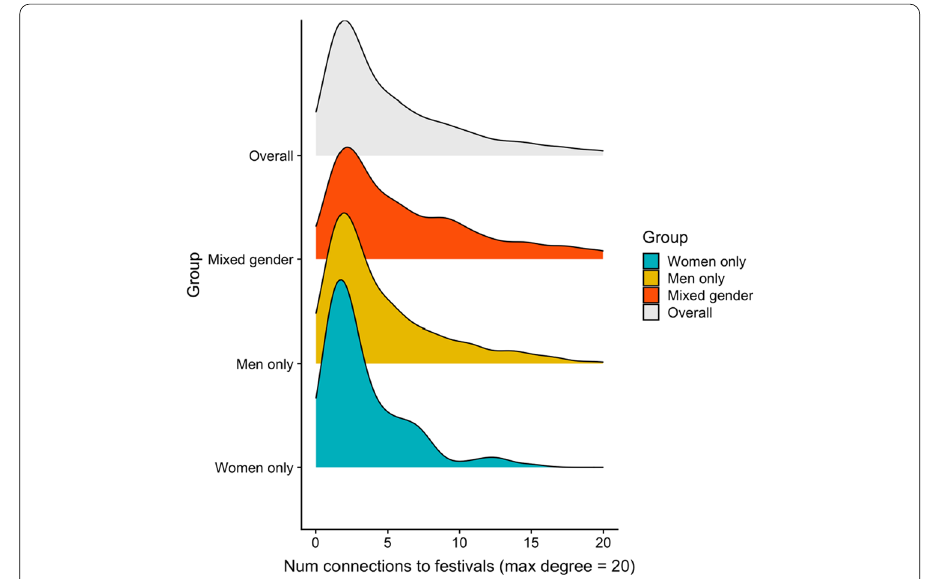
Fig. 6 Connectedness of films to festivals by gendered film core creative team composition